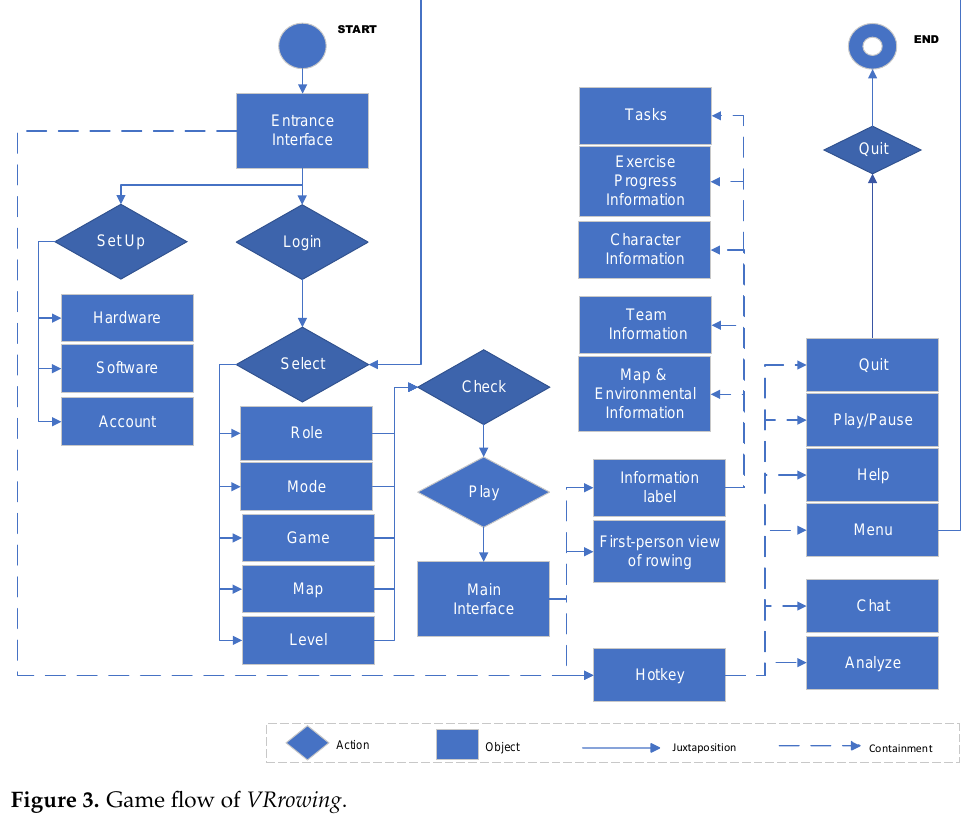
Figure 3. Game flow of VRrowing .